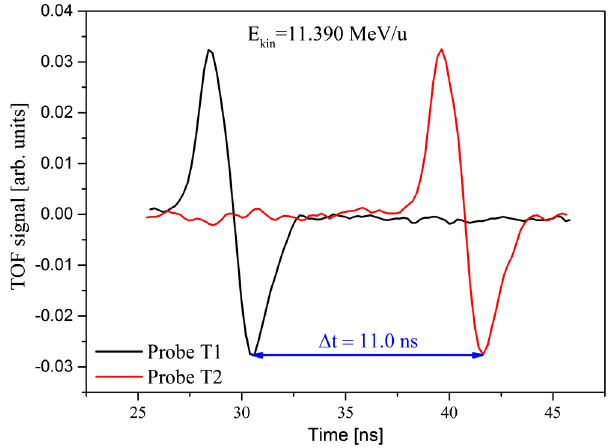
FIG. 12. Coarse measurement of the UNILAC proton beam energy applying the time-of-flight method with phase probe signals ( l ¼ 518 . 5 mm, Δ t ¼ 11 . 0 ns).